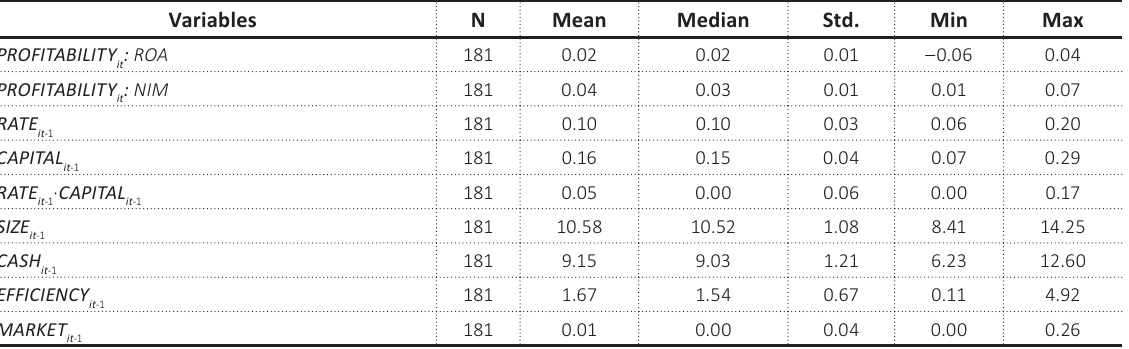
Table 1. Summary statistics